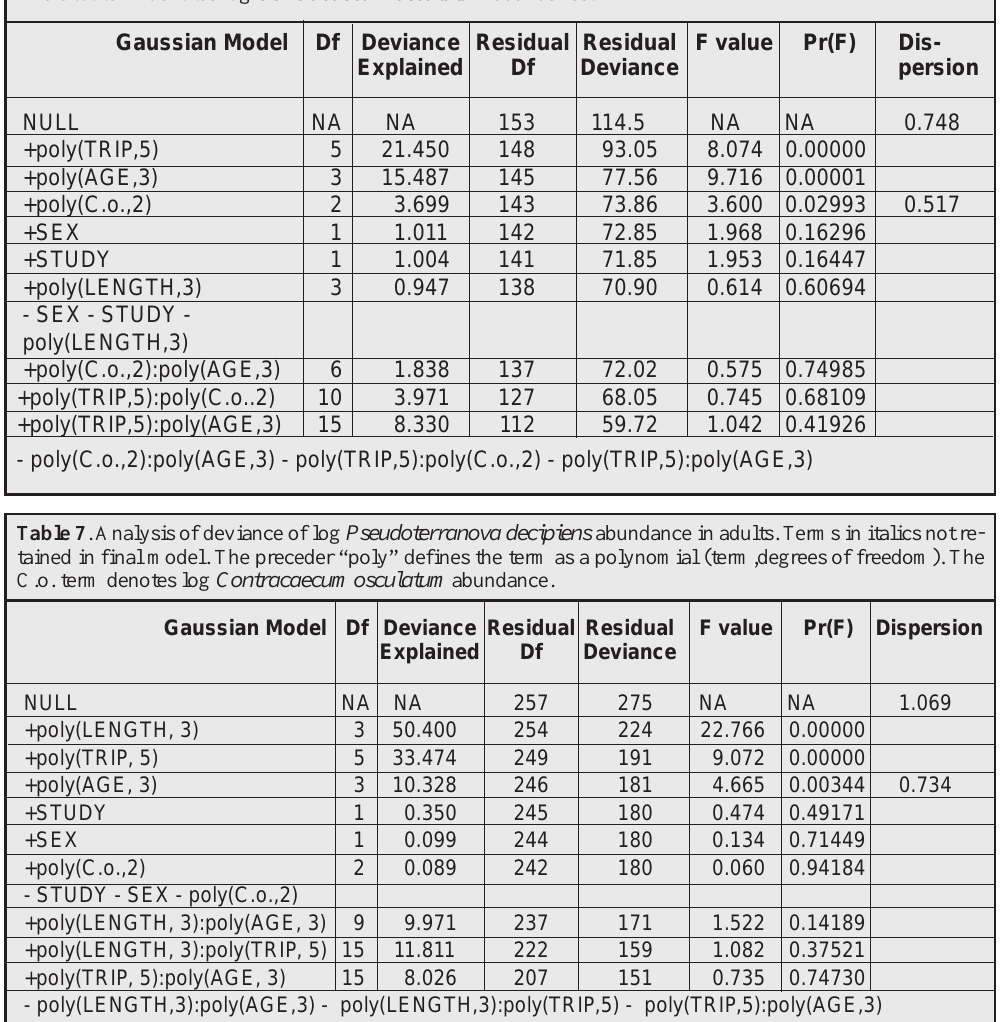
Table 8. Parameter estimates from analysis of deviance of grey seal log worm counts by life